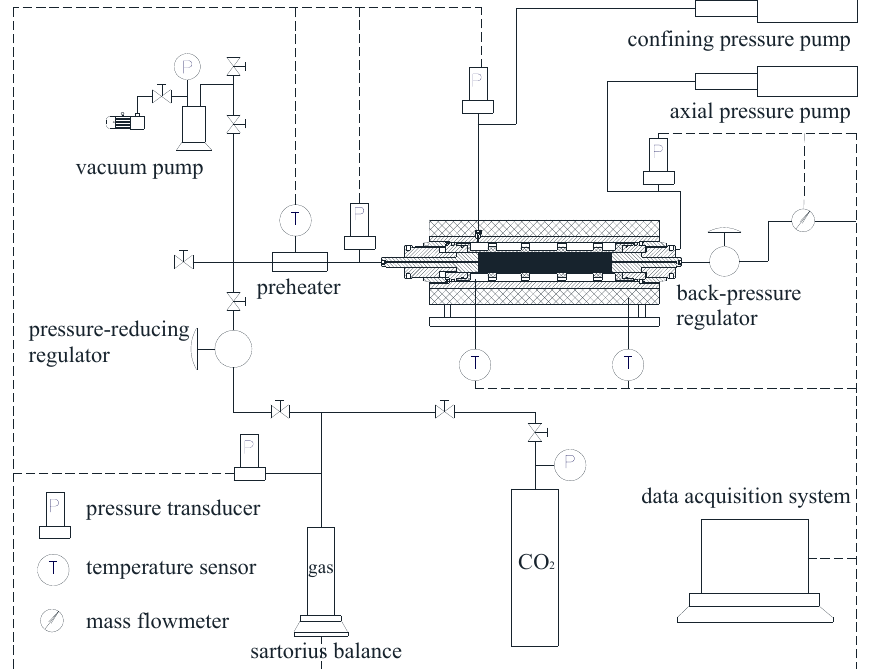
Figure 4. Schematic diagram of the Supercritical CO 2 Permeability Testing apparatus.